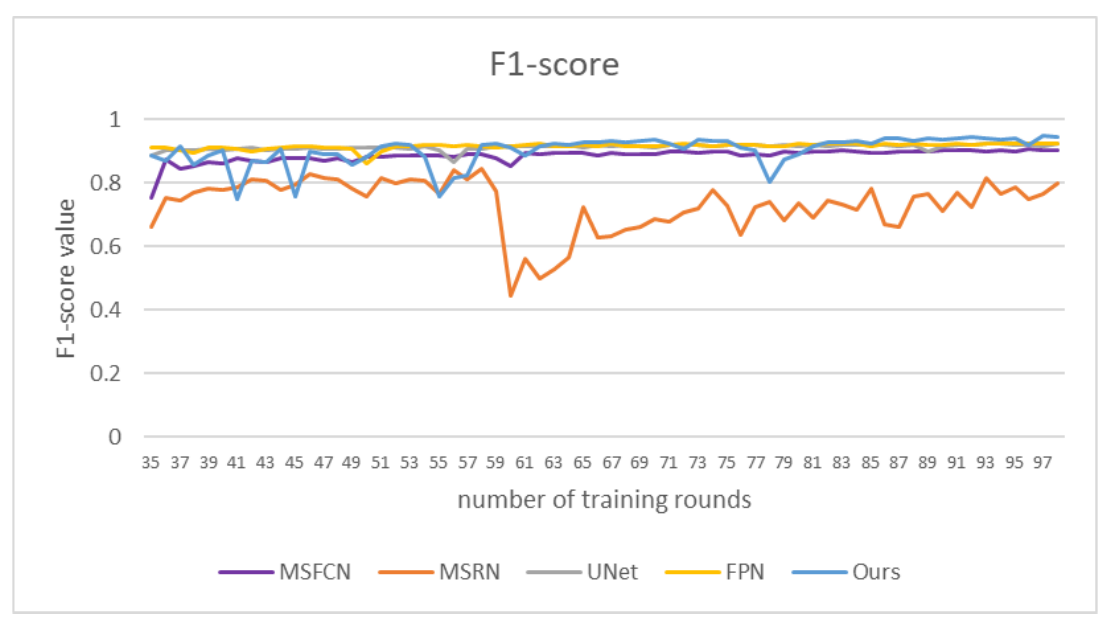
Figure 15. F 1-score of different models under certain epochs.